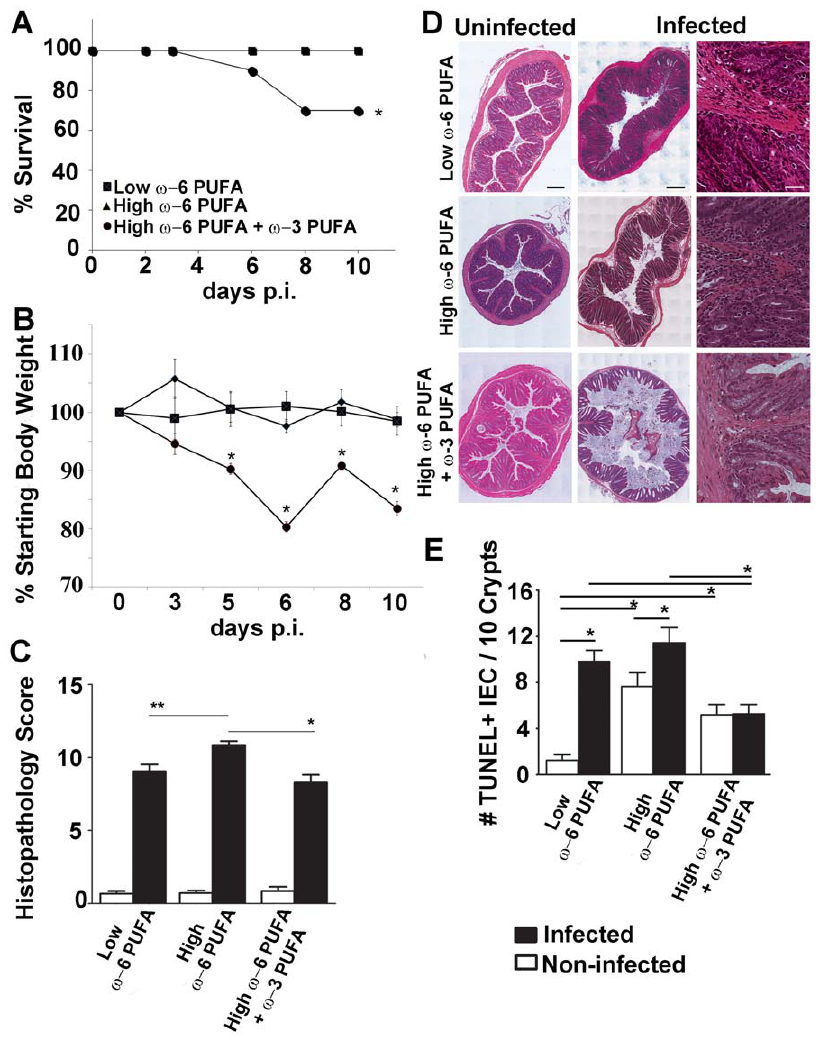
Figure 2. While v -3 PUFA supplementation prevents v -6 PUFA induced histopathologic severity, these mice suffered increased mortality and morbidity during C.rodentium infection. A) C57BL/6 mice fed v -6 PUFA rich diets supplemented with v -3 PUFA suffered increased mortality during infection with C. rodentium . 30% of mice fed v -3 PUFA required euthanization by 6–8 days p.i., in contrast to the low or high-fat v -6 PUFA groups. B) While both low or high-fat v -6 PUFA diets result in similar weight changes during infection with C. rodentium , the v - 3 PUFA supplemented group suffered significantly increased cachexia throughout days 5–10 p.i. C) Mice fed v -6 PUFA rich diets had the highest induction of histopathologic severity during C. rodentium -induced colitis while v -3 PUFA supplementation reduced this. D) Representative colon sections from diet groups were taken at 100 6 magnification and stitched together using Metamorph software (black scale bar=46.5 m m) or 200 6 magnification (white scale bar=20.7 m m). E) Colonic tissue sections were stained for TUNEL-positive cells. Colons from mice fed low and high-fat v